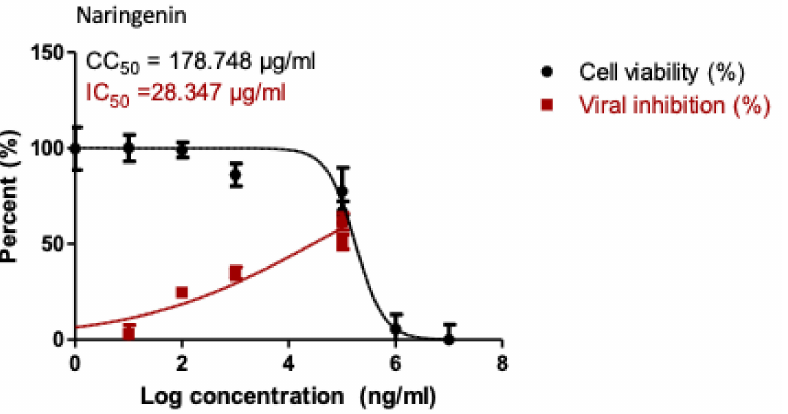
Figure 5. Dose-inhibition curves for naringenin. Inhibitory concentration 50% (IC50) values were calculated using nonlinear regression analysis of GraphPad Prism software (version 5.01) by plotting log inhibitor versus normalized